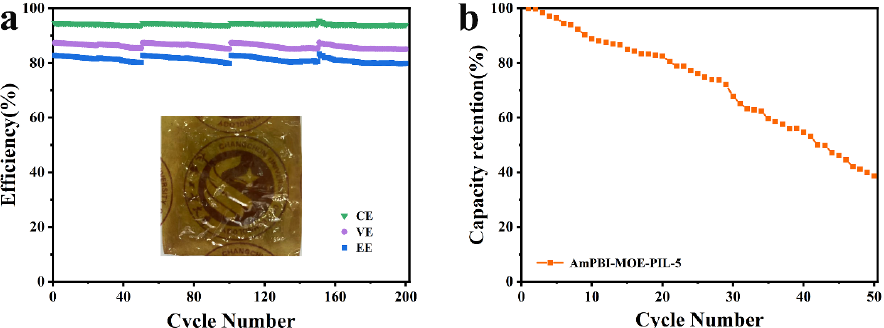
Figure 7. Cycling performances of the efficiencies ( a ), discharge capacity reduction ( b ) of AmPBI- MOE-PIL-5 at 60 mA cm −2 .